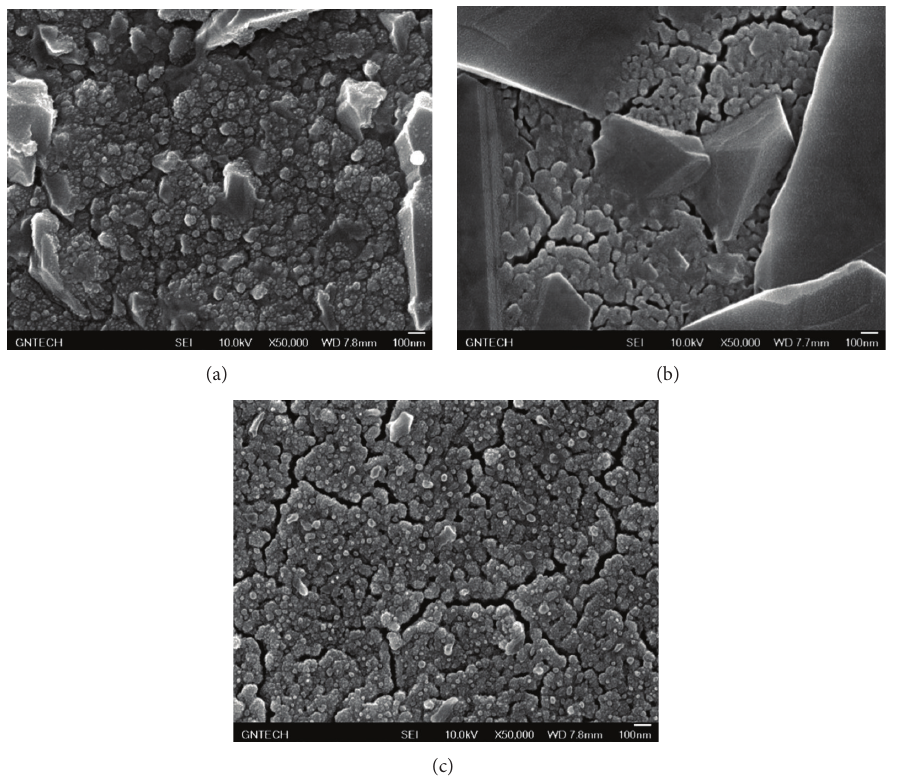
Figure 3: FE-SEM images of LiNiO 2 thin film with various annealing temperatures at (a) 400 ∘ C, (b) 500 ∘ C, and (c) 600 ∘ C, respectively. The annealing time was 10 minutes.